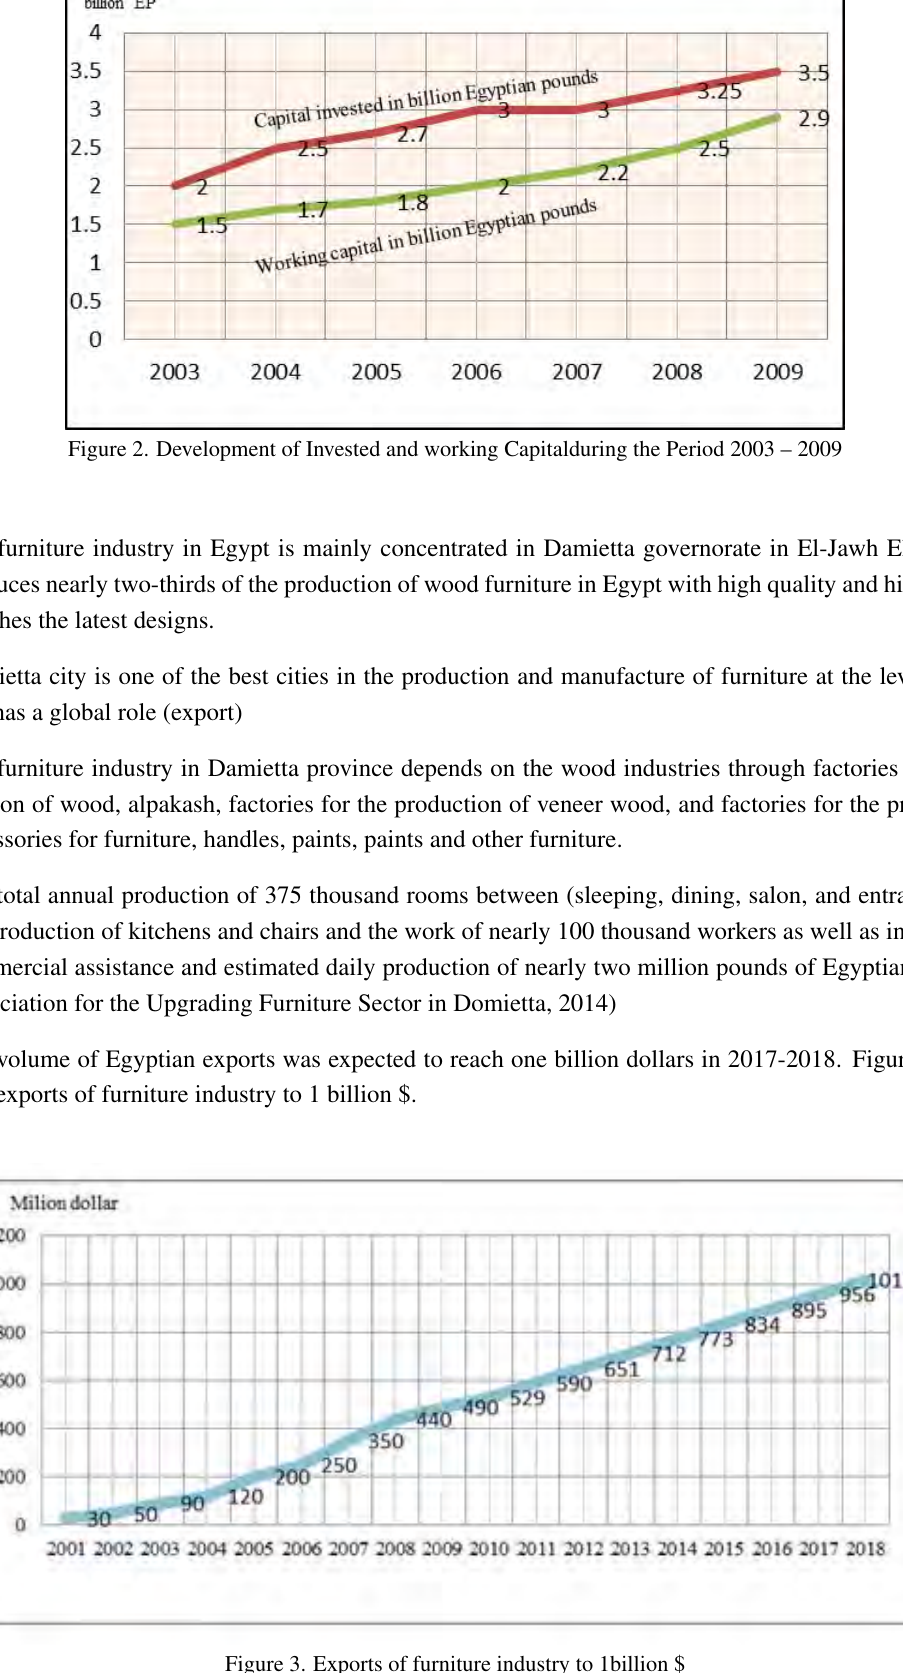
Figure 3. Exports of furniture industry to 1billion